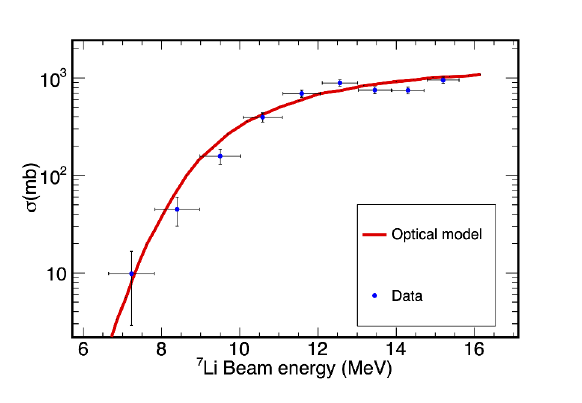
Figure 13. 7 Li + 40 Ar fusion cross sections near the barrier mea- sured with the ND-Cube TPC. Data taken for 3 hrs. at ≈ 1400 particles per second, with a P10 gas